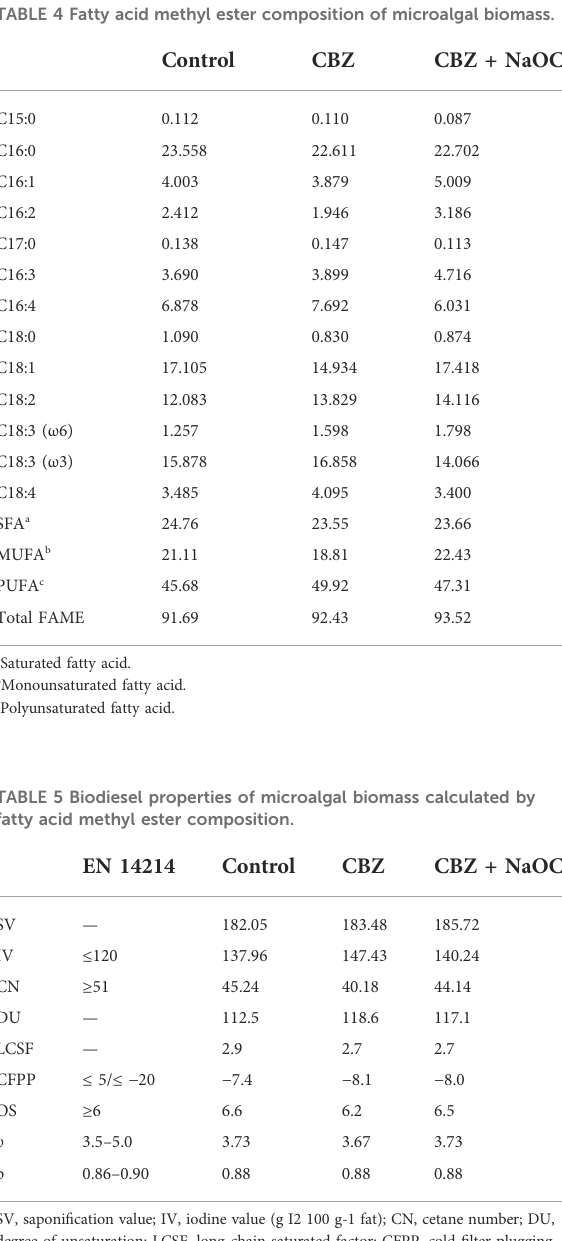
TABLE 4 Fatty acid methyl ester composition of microalgal biomass.